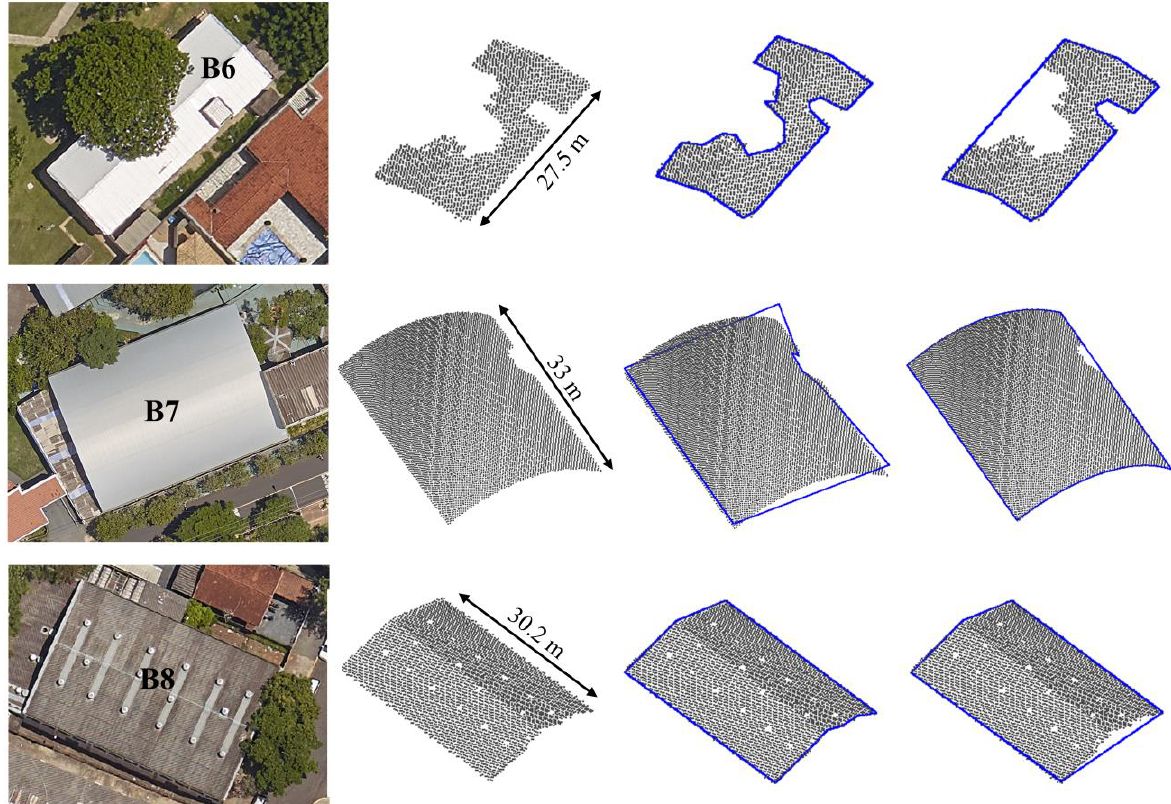
Figure 10. Buildings with occlusions selected in the Presidente Prudente/Brazil dataset. Aerial image patches ( first column ), points sampled over the building roof ( second column ), and results derived from ICDS ( third column ) and WICDS method ( fourth column ).